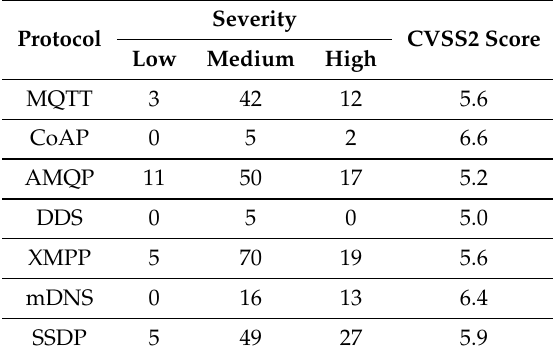
Table 4. Per protocol breakdown of the number of CVEs according to their severity and overall CVSS2 score.